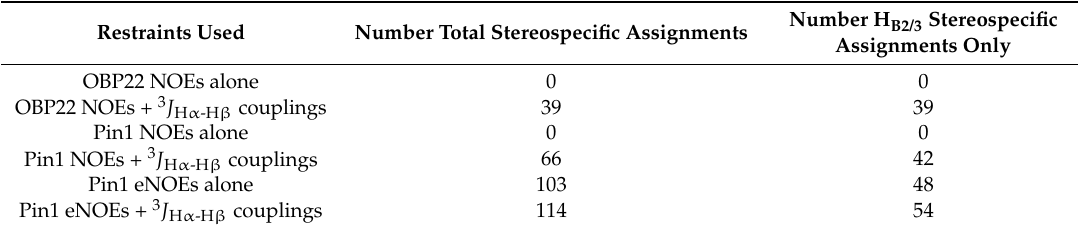
Table 1. Number of stereospecific assignments determined using the presented pulse sequence paired with CYANA